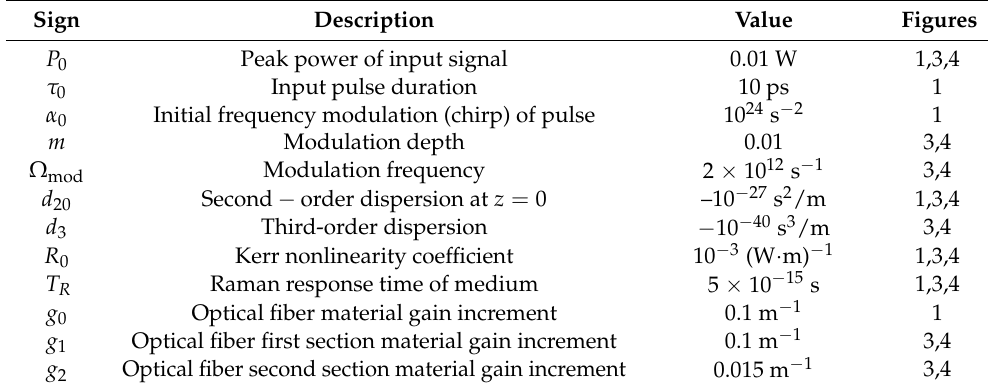
Table 1. Parameters used for calculations.